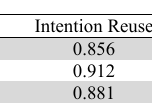
Table 2 Measurement Result Discriminate Validity Measurement